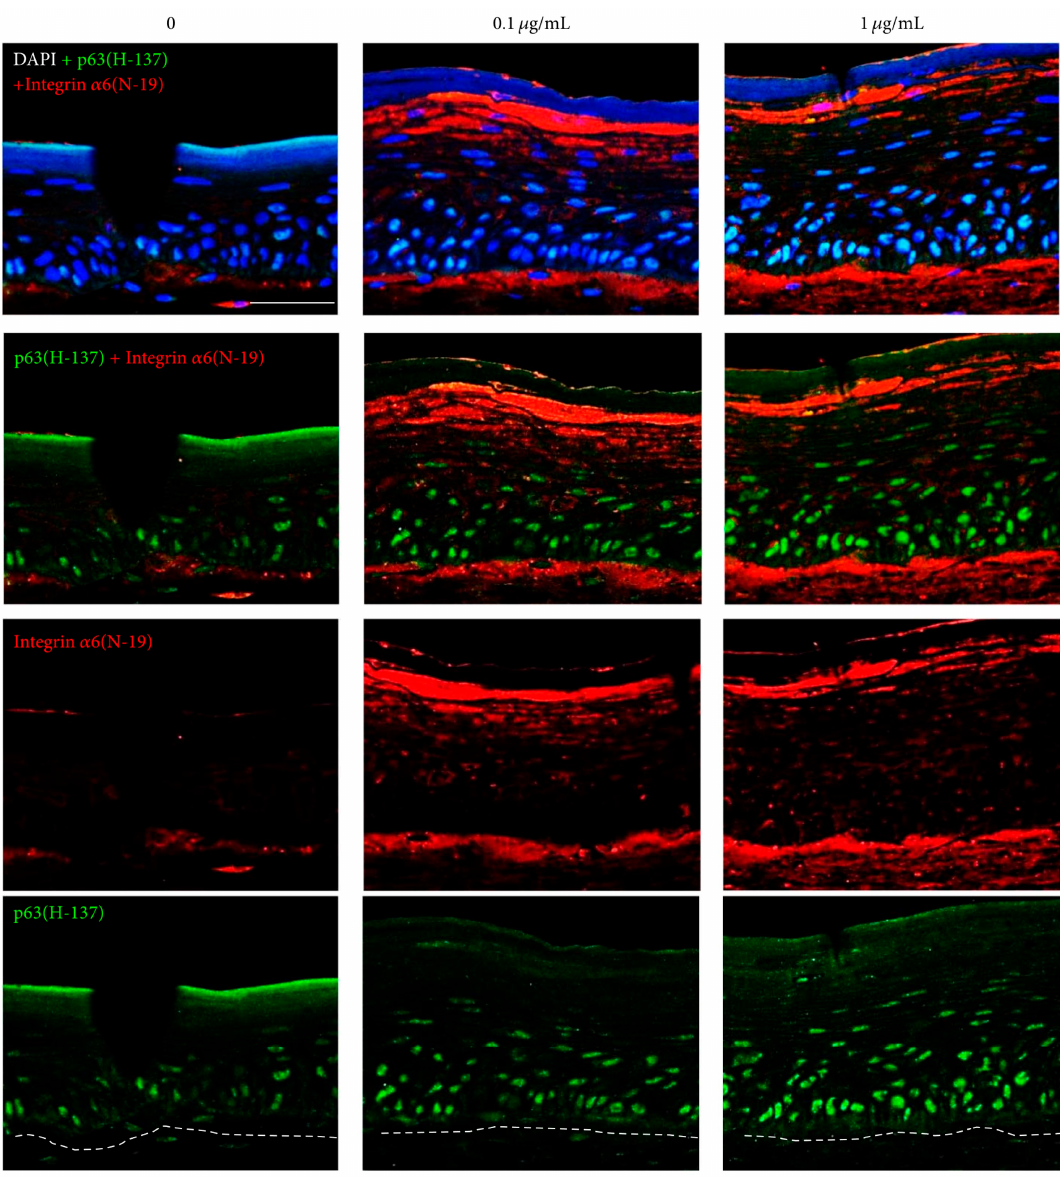
Figure 3. Immunohistochemical staining for integrin α 6 and p63 in alanine-cysteine-glutamine (ACQ)-treated skin equivalents. The expression of integrin α 6 and the number of p63-positive cells were increased significantly in skin equivalents incubated in the presence of ACQ (magnification × 200). (in the courtesy of Choi et al.